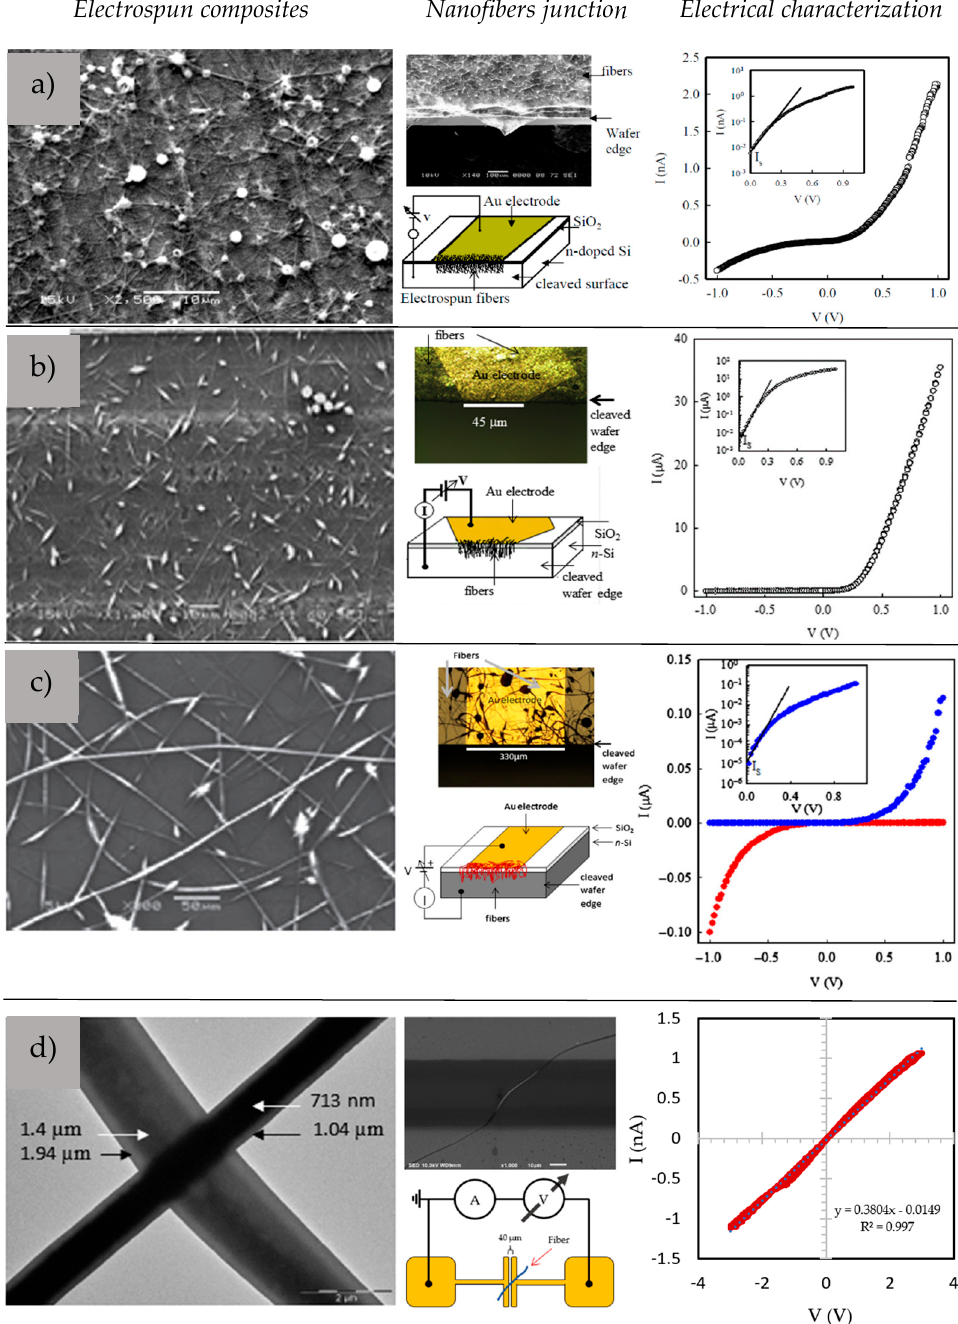
Figure 6. Semiconductive composite nanofibers. PVDF-TrFE/PEDOT ( a ), PLA/PANI ( b ), PLA/P3HT ( c ), and core–shell P3HT/BBL ( d ). Adapted with permission from [64,66–68].